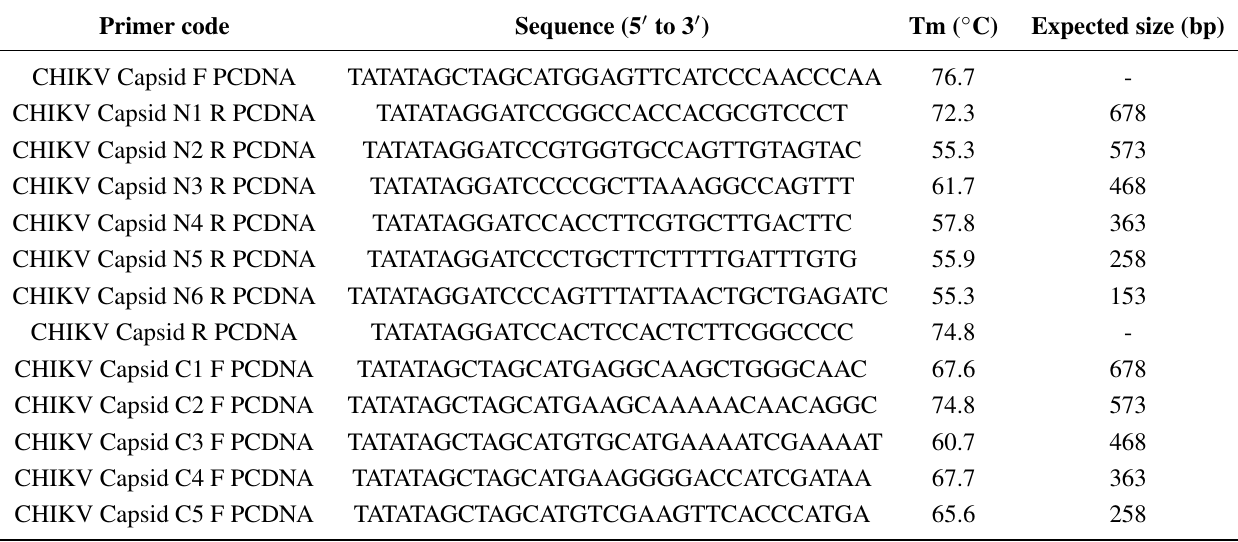
Table 1. Nucleotide sequences of CHIKV capsid truncation